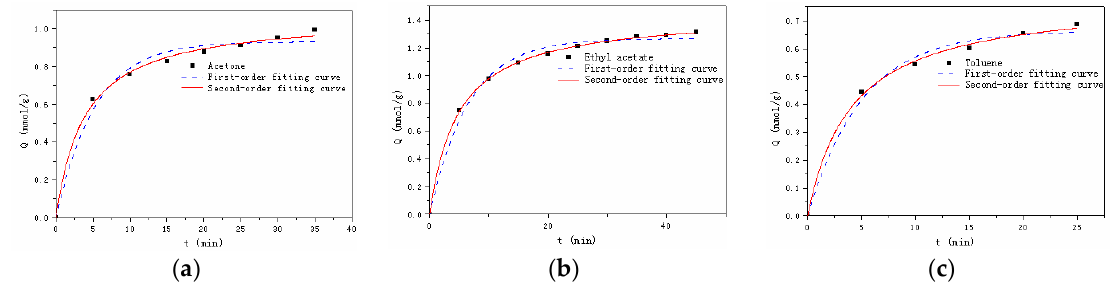
Figure 4. Kinetic adsorption process of Dt/S-1 (5 wt%) to acetate ( a ), ethyl acetate ( b ) and toluene ( c ). Table 5. Adsorption kinetics parameters of three probe VOCs. Q e = adsorption capacity at equilibrium. k 1 = pseudo first-order rate constant of adsorption. k 2 = pseudo second-order rate constant of adsorption. R 2 = correlation coefficient.